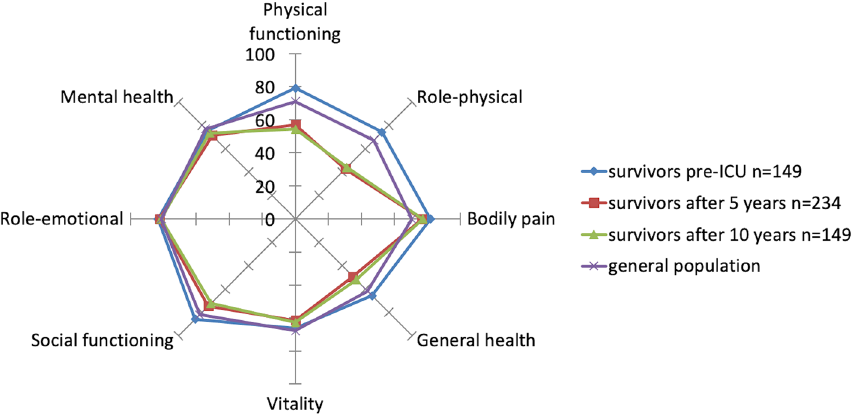
Figure 1. Comparisons of mean Short-form 36 scores of survivors before ICU admission, 5 and 10 years after ICU. Values in the different domains are all normalized to a scale of